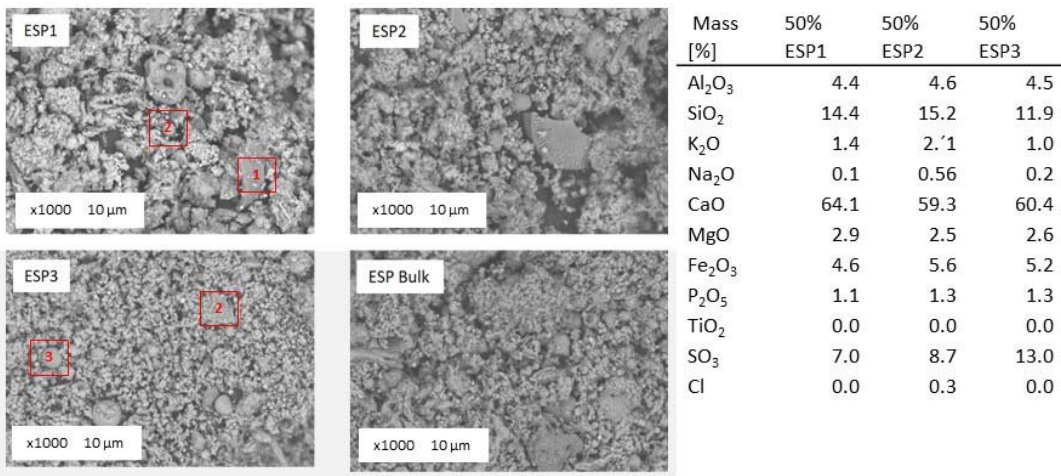
Figure 16. Backscattered electron images of FA from 50% thermal share Cynara co-combustion.